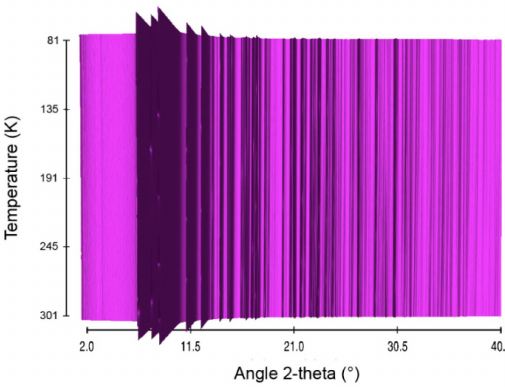
Figure 7. Sequential plot of the diffraction patterns of LiHB within the range of temperature 81–301